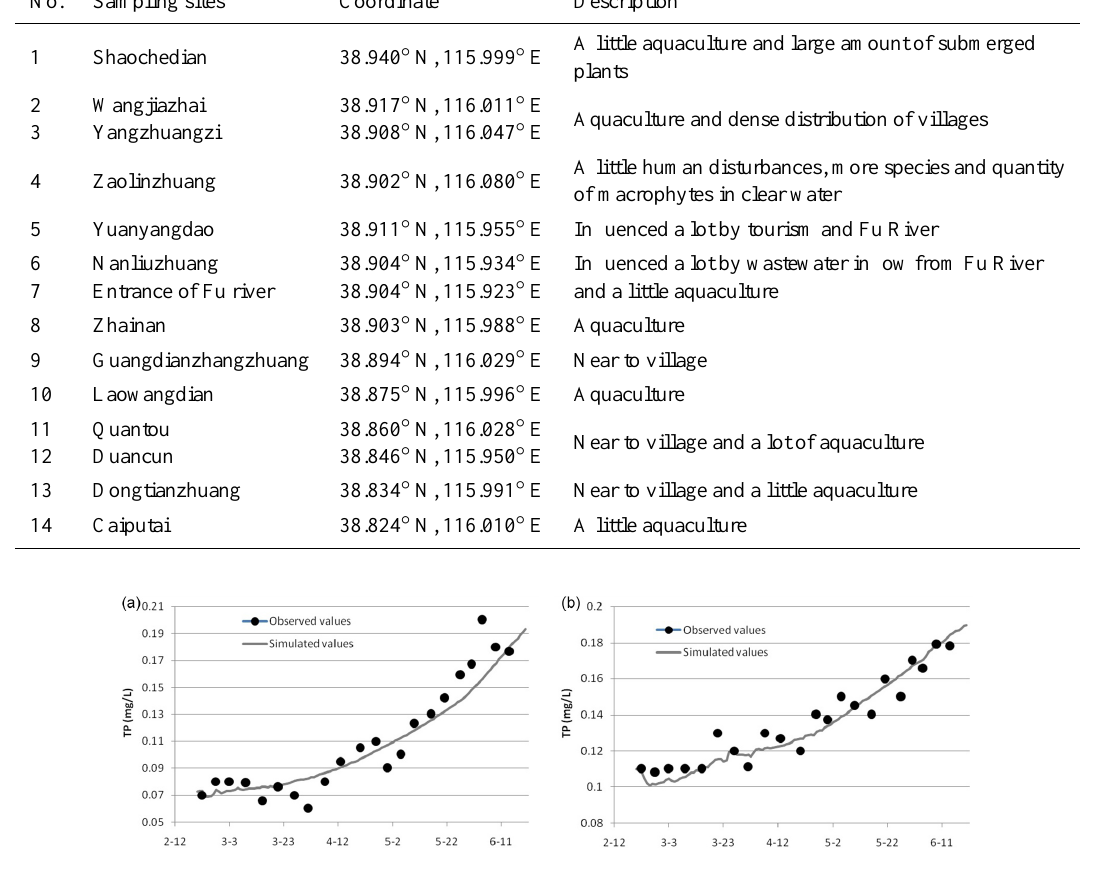
Table 1. Sampling site descriptions.